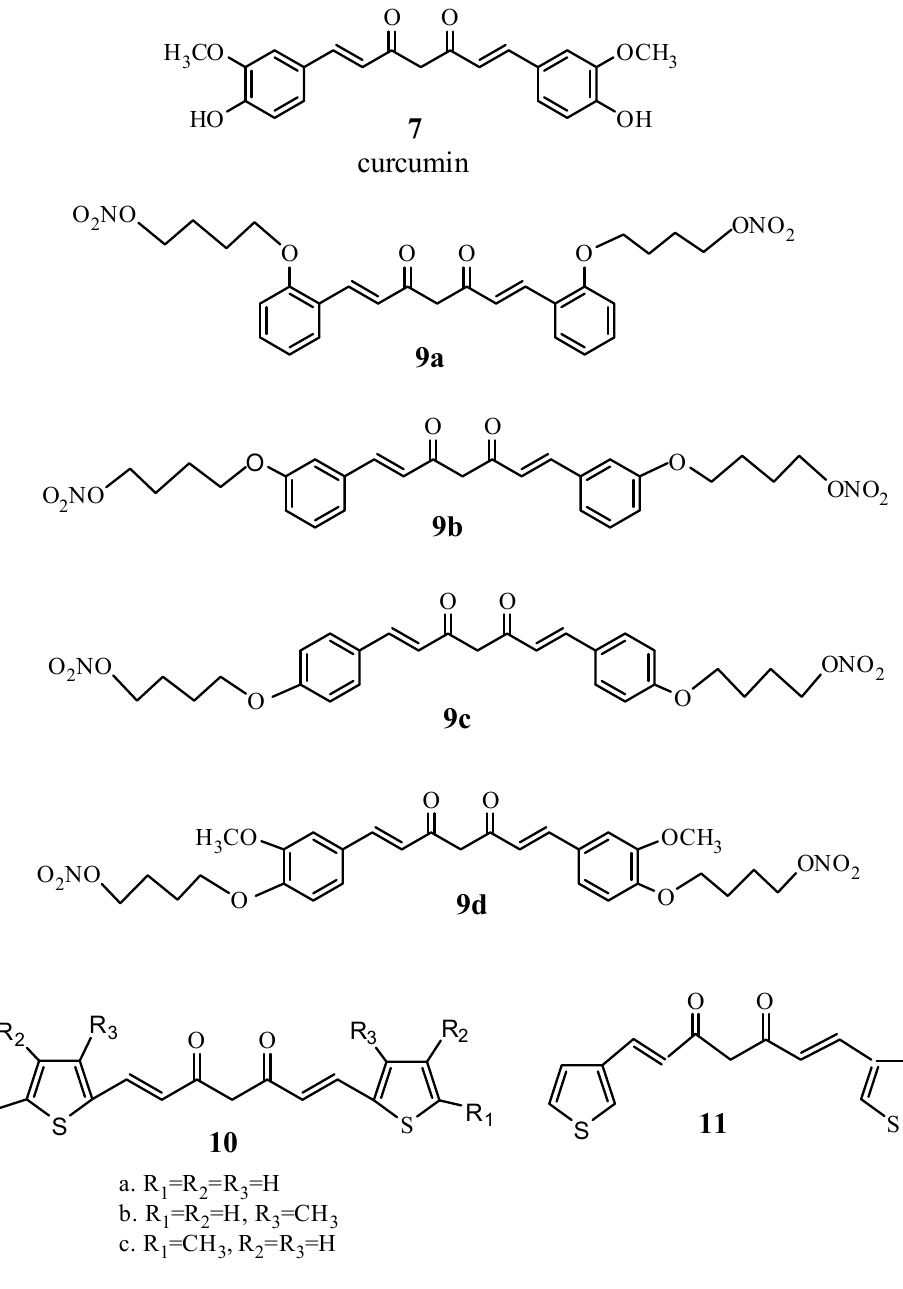
Figure 2. Synthesised thiophene and